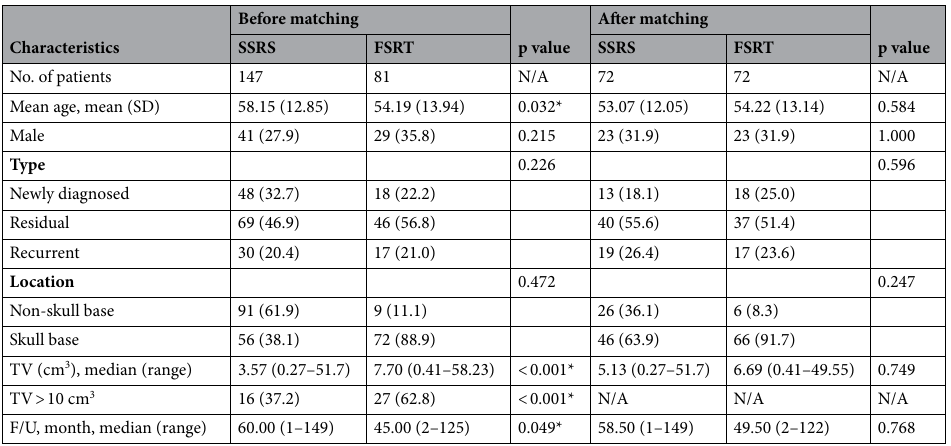
Table 4. Demographic characteristics of the SSRS and FSRT groups. F/U follow-up, NA not applicable, TV tumor volume.